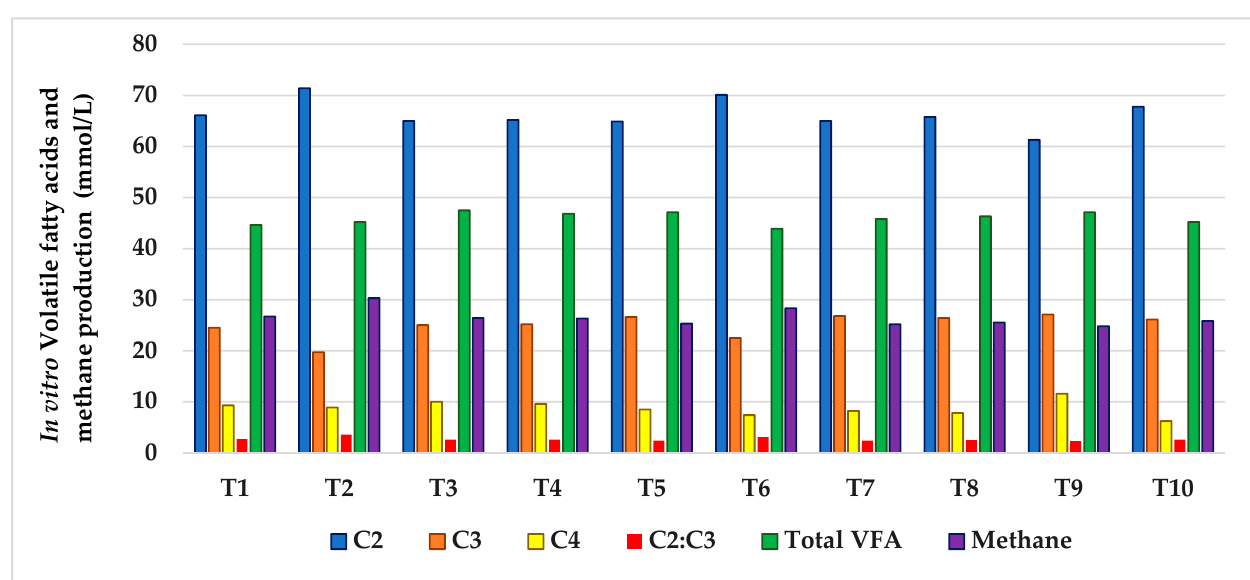
Figure 1. Effect of Cricket meal ( Gryllus bimaculatus ) (CM) on rumen volatile fatty acids (VFAs) and